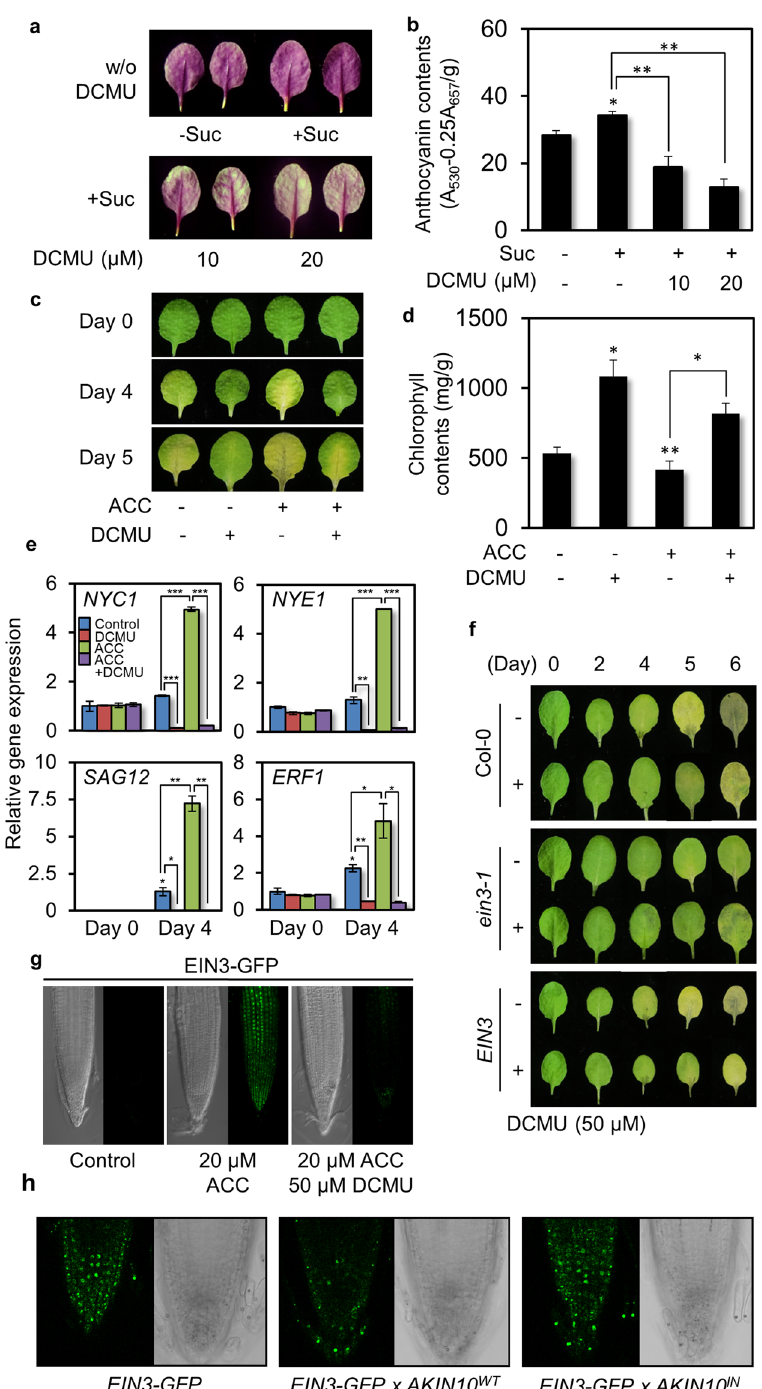
Figure 4. An AKIN10 elicitor DCMU delays EIN3-dependent ethylene inducible leaf senescence. ( a , b ) Anthocyanin accumulation was observed ( a ) and measured ( b ) in detached mature leaves in combination of sucrose and DCMU under light (n = 25). ( c , d ) Leaf degreening ( c ) was monitored and chlorophyll contents ( d ) were measured with detached mature leaves in combination of ACC and DCMU under darkness (n = 25). Values are means of triplicates with standard error bars ( * p < 0.001; ** p < 0.01; *** p < 0.05). ( e ) Expression of marker genes for senescence and ethylene signaling was monitored using quantitative RT-qPCR. EIF4a served as a control. ( f ) Leaf degreening was observed for Col-0, ethylene insensitive ein3-1 and ethylene oversensitive EIN3- expressing transgenic lines ( EIN3 ) in the absence and presence of DCMU. ( g ) Fluorescence signals were observed in root tips of EIN3-GFP expressing transgenic Col-0 in the presence of ACC and/or DCMU under confocal microscopy. ( h ) Fluorescence signals were observed in root tips of transgenic lines expressing EIN3- GFP and AKIN10 WT or AKIN10 IN in the presence of ACC under confocal microscopy. All experiments were repeated with consistent results. Representative results were